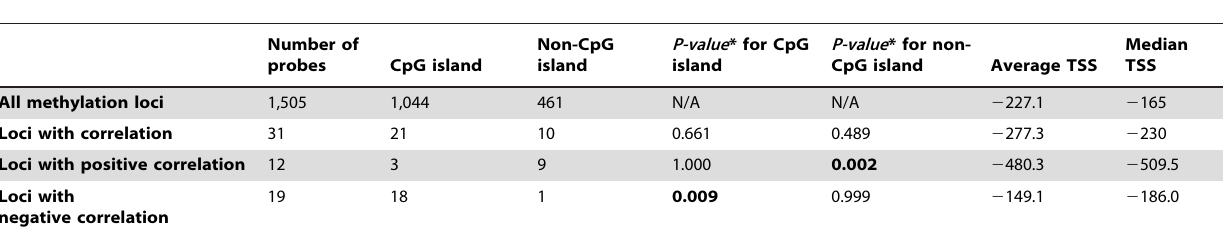
Table 3. Relationship to CpG islands and TSS for genes with methylation-expression correlations identified by computing a Pearson correlation coefficient.